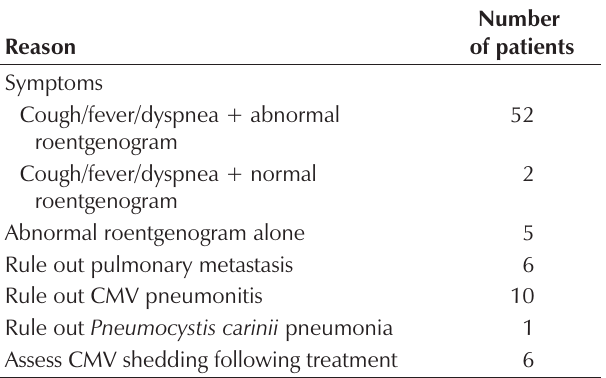
Reasons for bronchoscopy